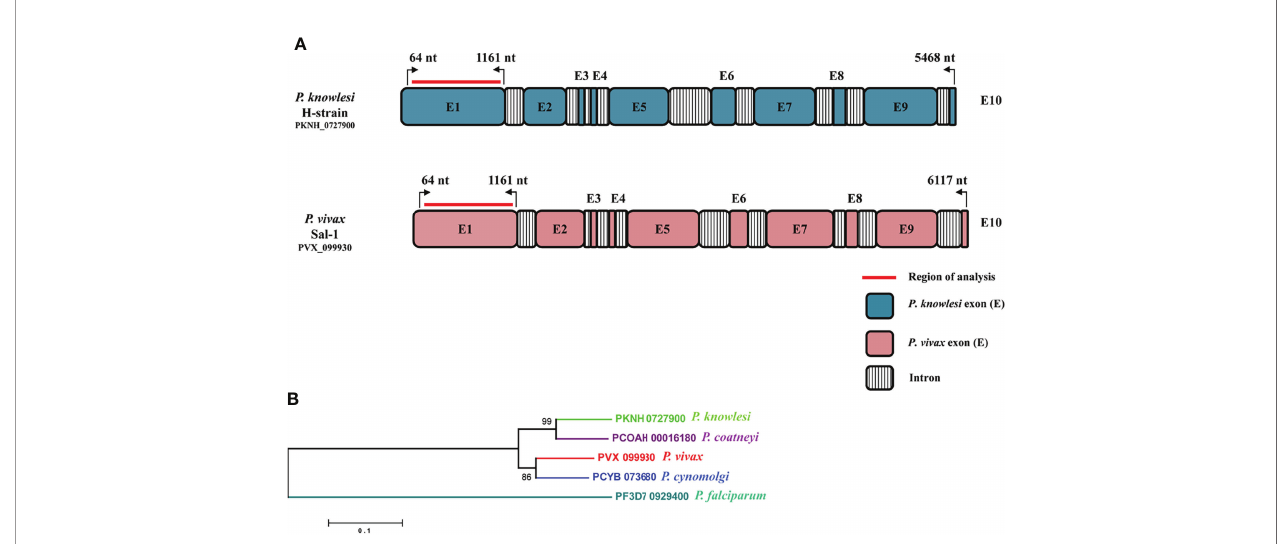
FIGURE 1 | (A) Schematic representation of the P. knowlesi full-length RhopH2 gene in H-strain (PKNH_0727900, 5,468 bp) and P. vivax sal-1 strain (PVX_099930, 6,117 bp). The introns and exons were determined as described in PlasmoDB (www.plasmodb.org). The number on top with bend arrows represents position of the nucleotides in P. knowlesi and in P. vivax. The bold red line indicates the region of analysis for this study. (B) Interspecies phylogenetic relationships between RhopH2 full-length amino acid sequences of orthologs i.e., P. knowlesi (PKNH_0727900), P. coatneyi (PCOAH_00016180), P. vivax (PVX_099930), P . cynomolgi (PCYB_073680), and P. falciparum